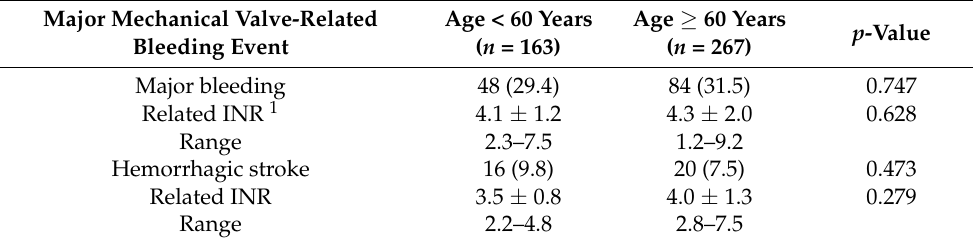
Table 11. Major mechanical valve-related bleeding events under vs. above the age of